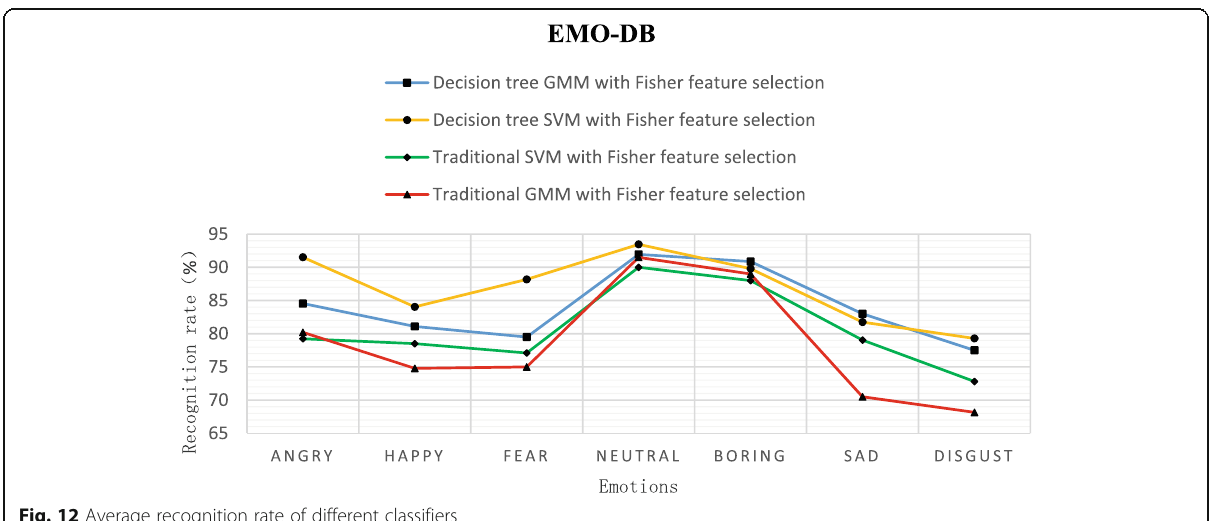
Fig. 12 Average recognition rate of different